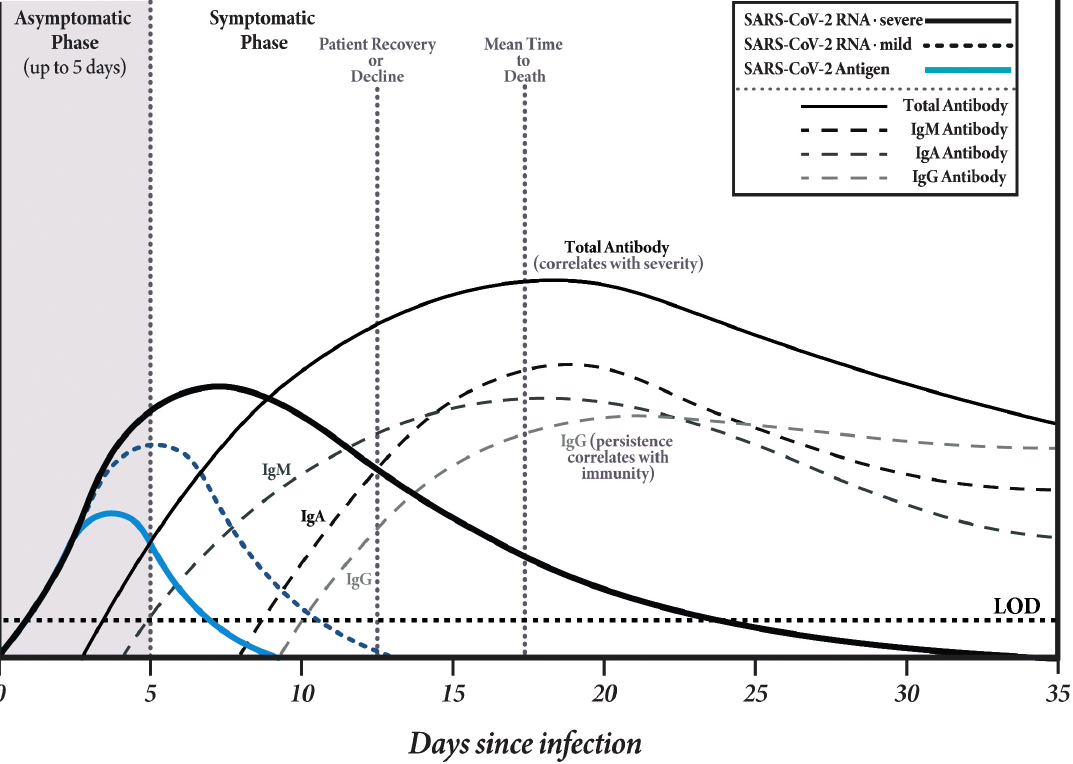
Figure 1. Timeline of viral RNA shedding and development of an immune